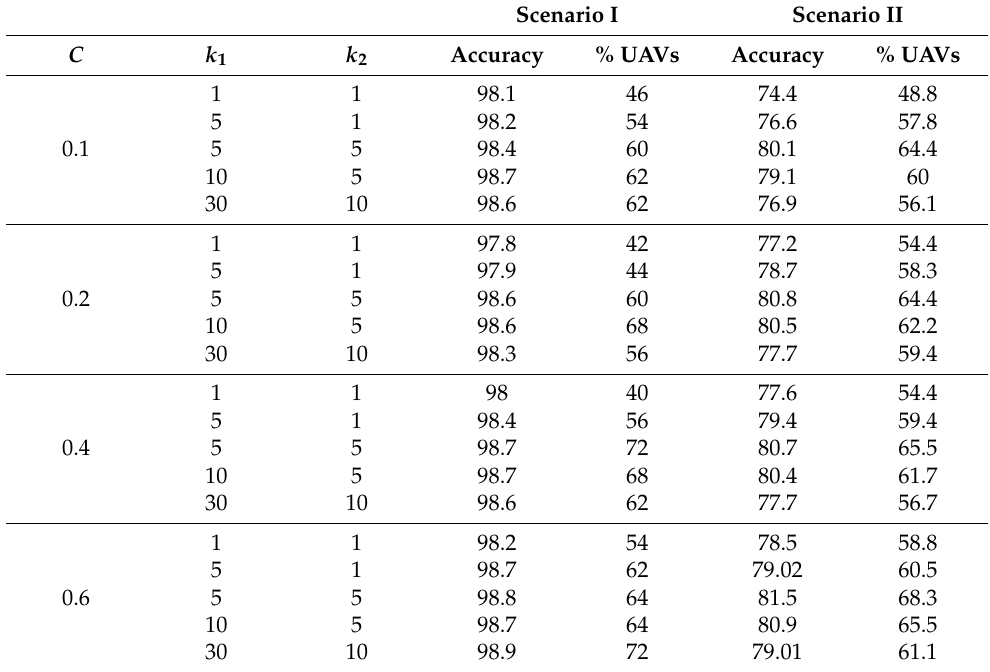
Table 2. Performance of the hierarchical FL with different choices of hyperparameters C , k 1 , and k 2 for Scenarios I and II after 50 global